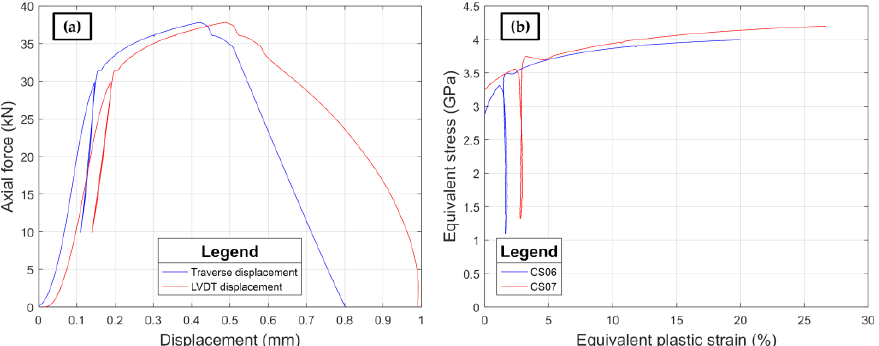
Figure 9. ( a ) Recorded quasi-static data for the CS06 sample (with grease); ( b ) equivalent stress versus equivalent plastic strain curves for two quasi-static tests.